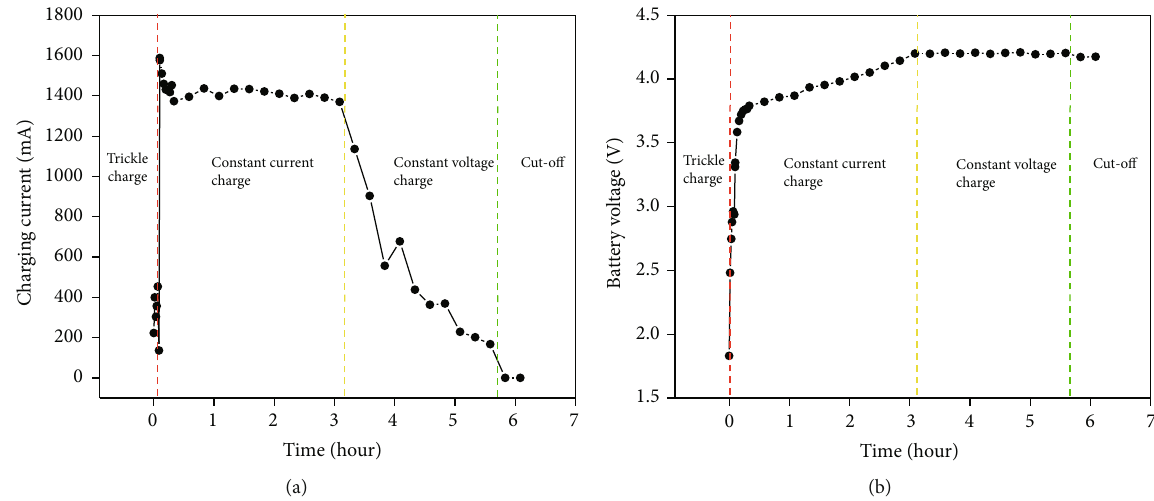
Figure 15: Charging controller test result: (a) charging current vs. time; (b) battery voltage vs. time. Table 3: E ffi ciency test result with MPPT and without MPPT. E ffi Irradiance